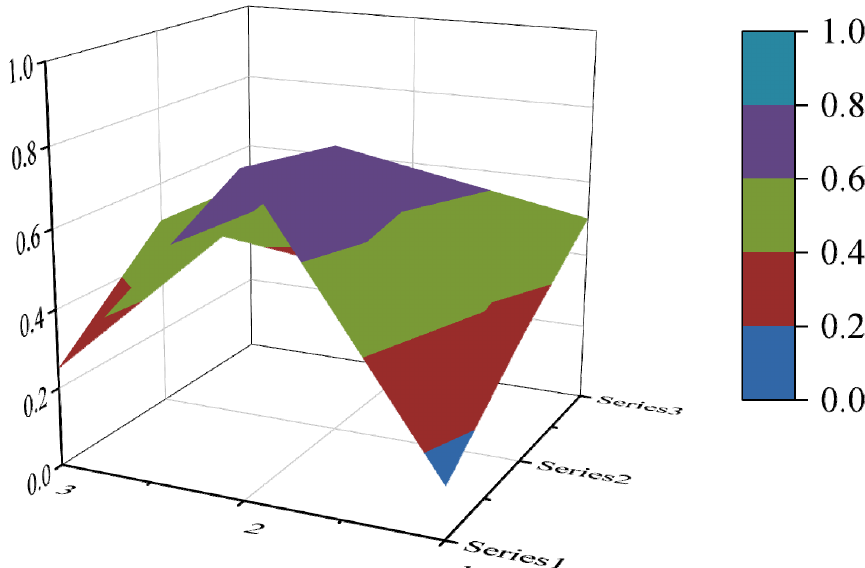
Figure 11. The PMC surface of P10.